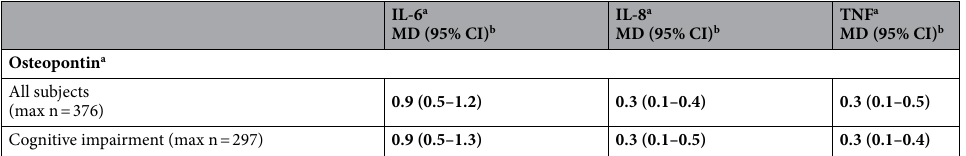
Table 7. Associations between osteopontin and inflammatory markers, expressed in mean difference (MD) and 95% confidence interval (CI). Bold values indicates p < 0.05 using linear regression. IL-6, interleukin-6; IL-8, interleukin-8; TNF, tumor necrosis factor; NCI, non-cognitive impairment; CIND, cognitive impairment no dementia; max n, maximum number; MD, mean difference; CI, confidence interval. a Log-transformed. b Adjusted for age, hypertension, hyperlipidemia, diabetes and cardiovascular